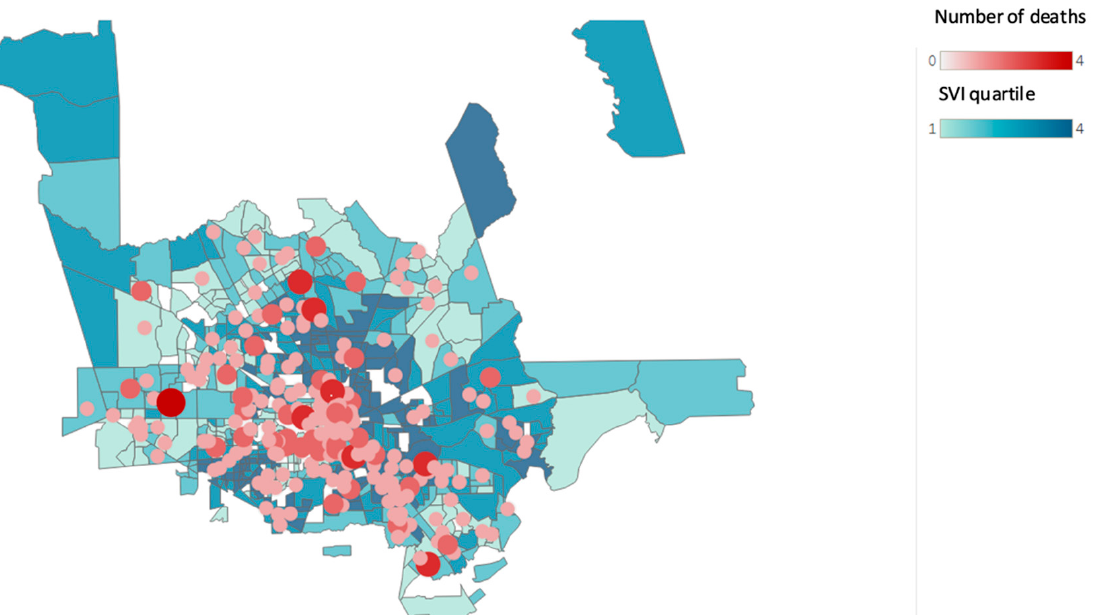
Figure 3. Non-hospital opioid-related overdose deaths by Social Vulnerability Index (SVI) according to census tract for the year 2020. (Source: Harris County Institute of Forensic Sciences, 2015–2021, U.S. Census Bureau; Centers for Disease Control and Prevention and the Agency for Toxic Sub- stances and Disease Registry; and the U.S. Department of Housing and Urban Development Zip